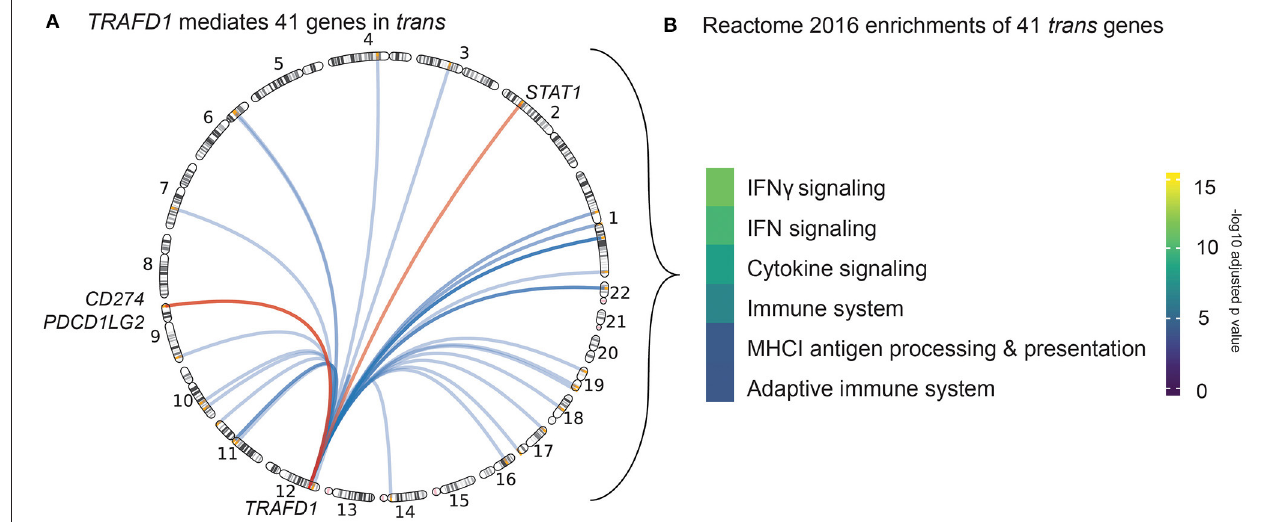
FIGURE 3 | Trans genes action and function. (A) Circle genomic plot depicting the location of the 41 genes trans-mediated by TRAFD1 . The three genes also prioritized by our cis -eQTL analysis are named (red). (B) Results of the REACTOME gene set enrichment analysis of TRAFD1 -mediated genes. Color code denotes the significance (-log 10 adjusted p -value) of each biological